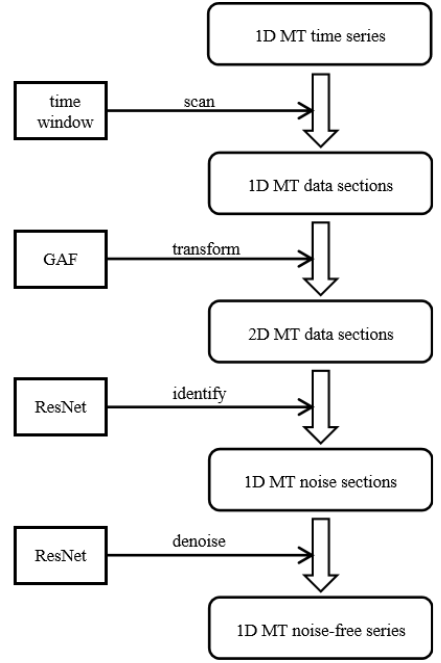
Figure 3. The whole workflow of our study.